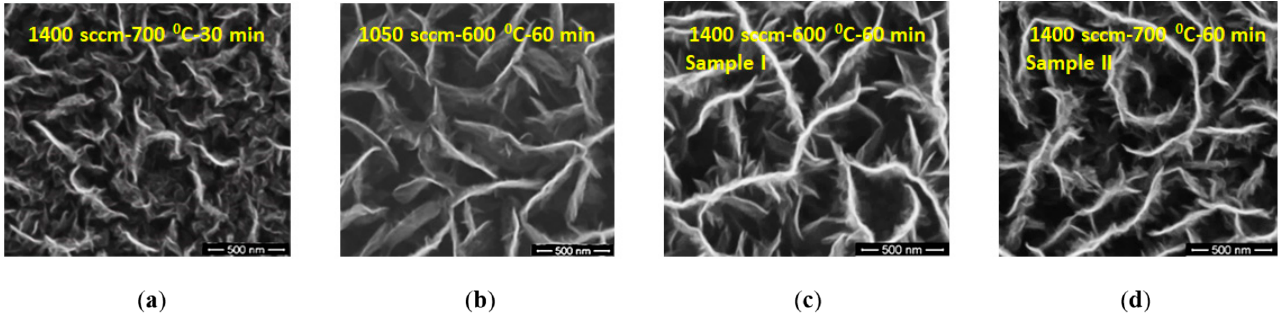
Figure 2. The SEM images for the CNWs grown at ( a ) 1400 sccm-700 °C-30 min, ( b ) 1050 sccm-600 °C-60 min, ( c ) 1400 sccm-600 °C-60 min and ( d ) 1400 sccm-700 °C-60 min.